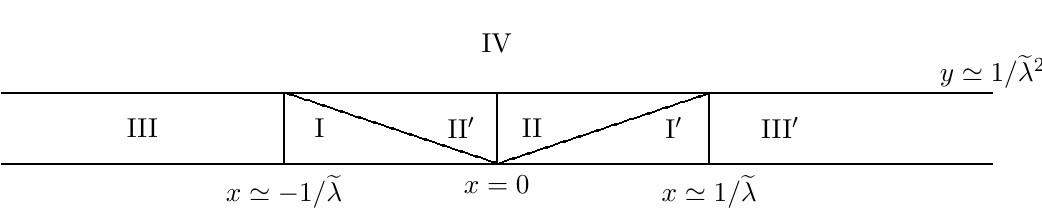
Figure 5 . This figure shows the covering of the moduli space of C-C-O amplitude on the disk by various Feynman diagrams. The horizontal axis labels x — the position of the open string puncture on the real axis and the vertical axis labels y , the position of the second closed string puncture on the imaginary axis. The first closed string puncture is situated at i . We use only the leading order results for large e λ to plot the boundaries of various regions; the full expressions may be found in the